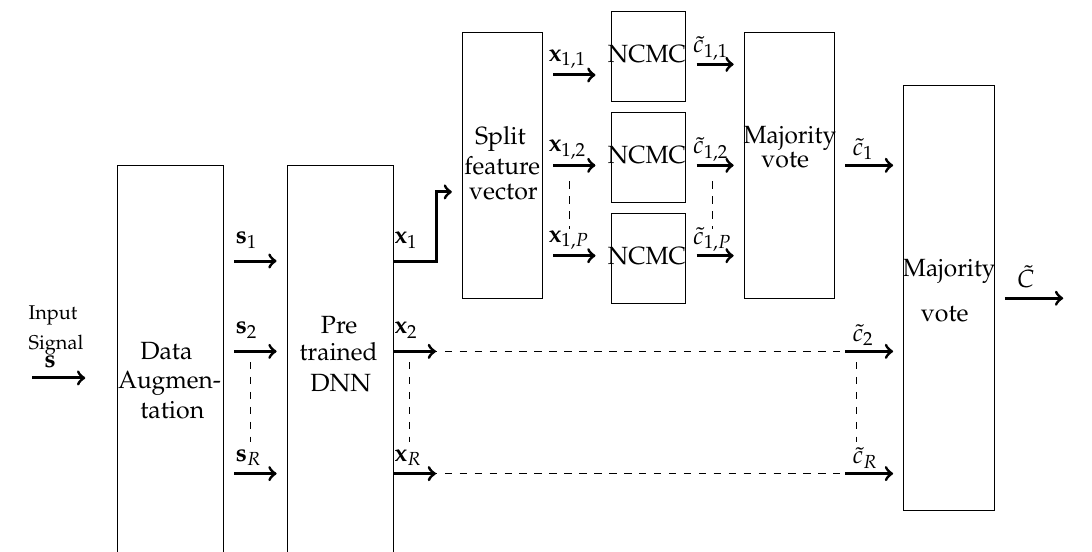
Figure 1. Overview of the proposed method. Given an input signal s , we first use data augmentation to generate a multiple version of the input signal ( s r ) feature extraction and obtain the corresponding feature vectors ( x r ) each feature vector x r into P equal parts